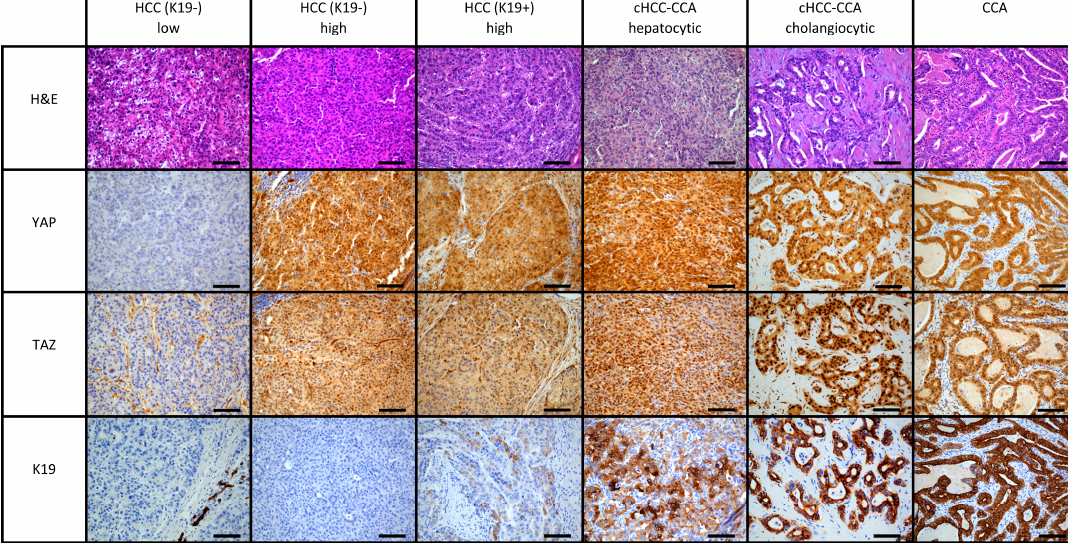
Figure 1. Representative immunohistochemistry images of YAP, TAZ, Keratin 19 (K19) is shown for hepatocellular carcinoma (HCC) K19 − , HCC K19 + , combined hepatocellular–cholangiocarcinoma (cHCC-CCA), and cholangiocarcinoma (CCA) cases. The spectrum of HCC Keratin 19 − is illustrated by a case that shows the absence of YAP and TAZ in the tumor cells, while another case of HCC Keratin 19 − illustrates high expression of YAP and TAZ. HCC K19 + is represented by a case that has high YAP and TAZ expression. The hepatocellular and cholangiocellular components show expression in the cytoplasm and nucleus. CCA shows positivity for YAP and TAZ. All images were taken at 20×. Scale bar: 100 µm.